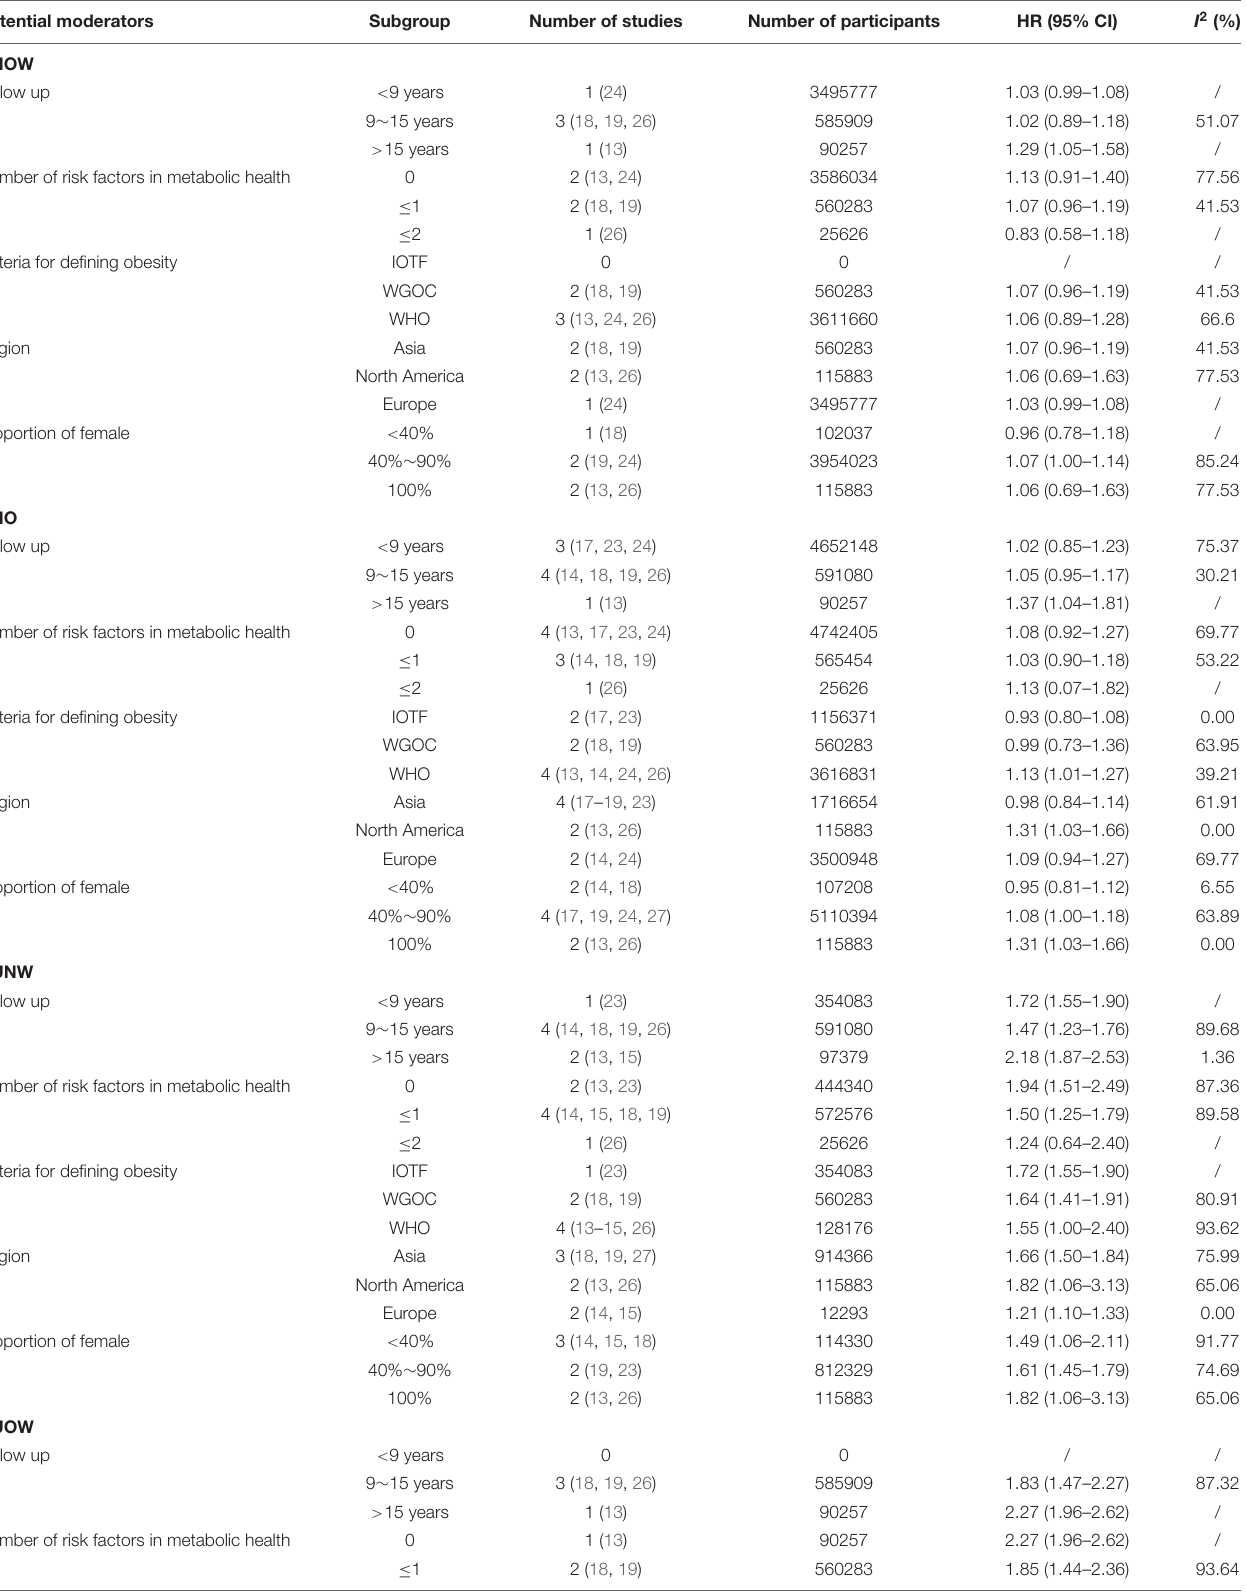
TABLE 3 | Subgroup analysis for the association between the metabolic phenotypes and risk of